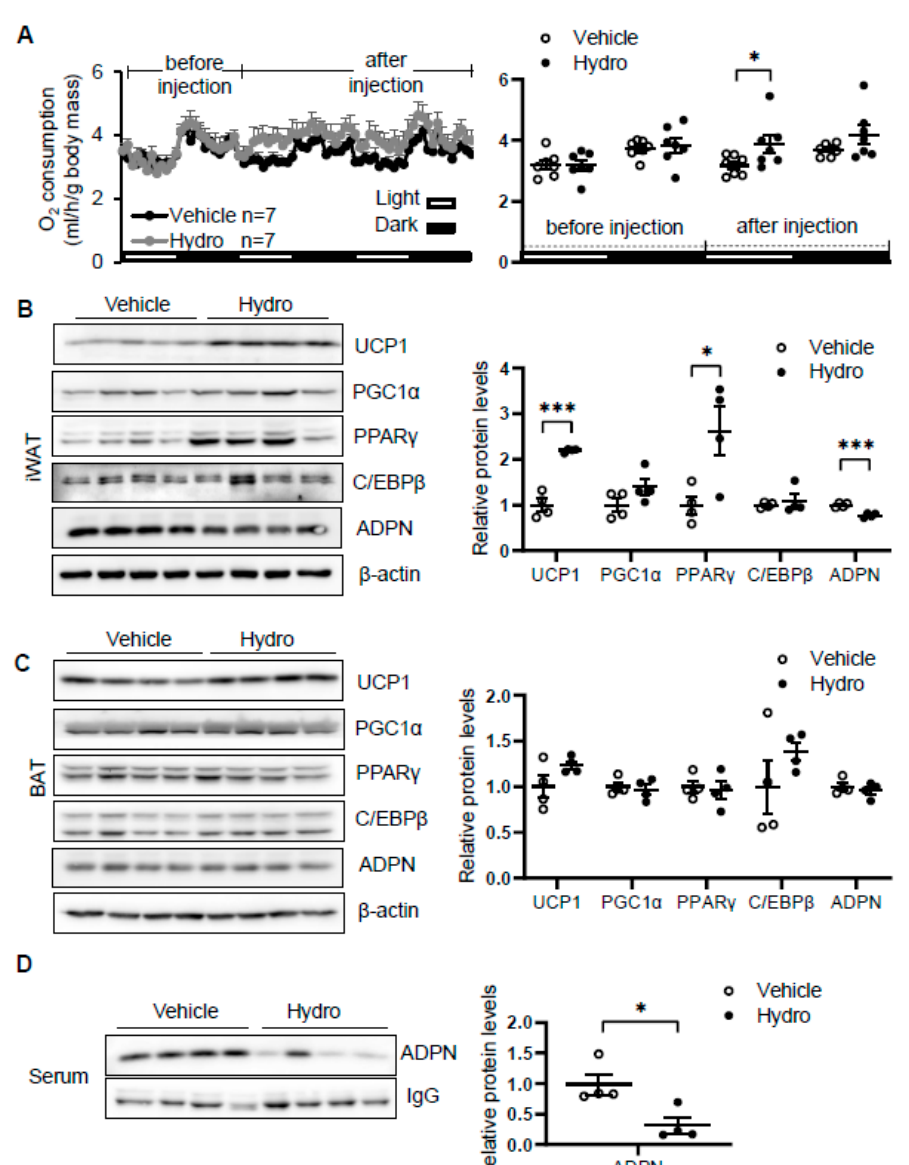
Figure 2. Hydrocortisone increases energy expenditure and suppresses adiponectin expression in adipose tissue. ( A ) Administration of hydrocortisone increased oxygen (O 2 ) consumption of wild type (WT) mice. The average O 2 consumption was normalized to whole-body mass. Hydrocortisone treatment upregulated the expression of thermogenesis genes Ucp1 and Ppar γ and downregulated the protein levels of adiponectin in iWAT ( B ) but not in BAT ( C ). ( D ) Hydrocortisone treatment decreased the levels of adiponectin in serum. White dots, vehicle group ( n = 4); black dots, hydrocortisone group ( n = 4). Hydro, hydrocortisone. The statistical data are presented as the mean ± S.E.M. * p < 0.05, *** p <